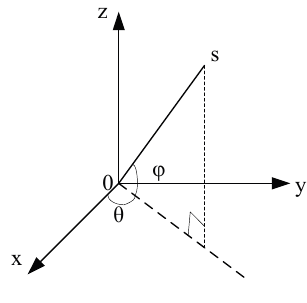
Figure 6. MEMS acoustic vector directional model.